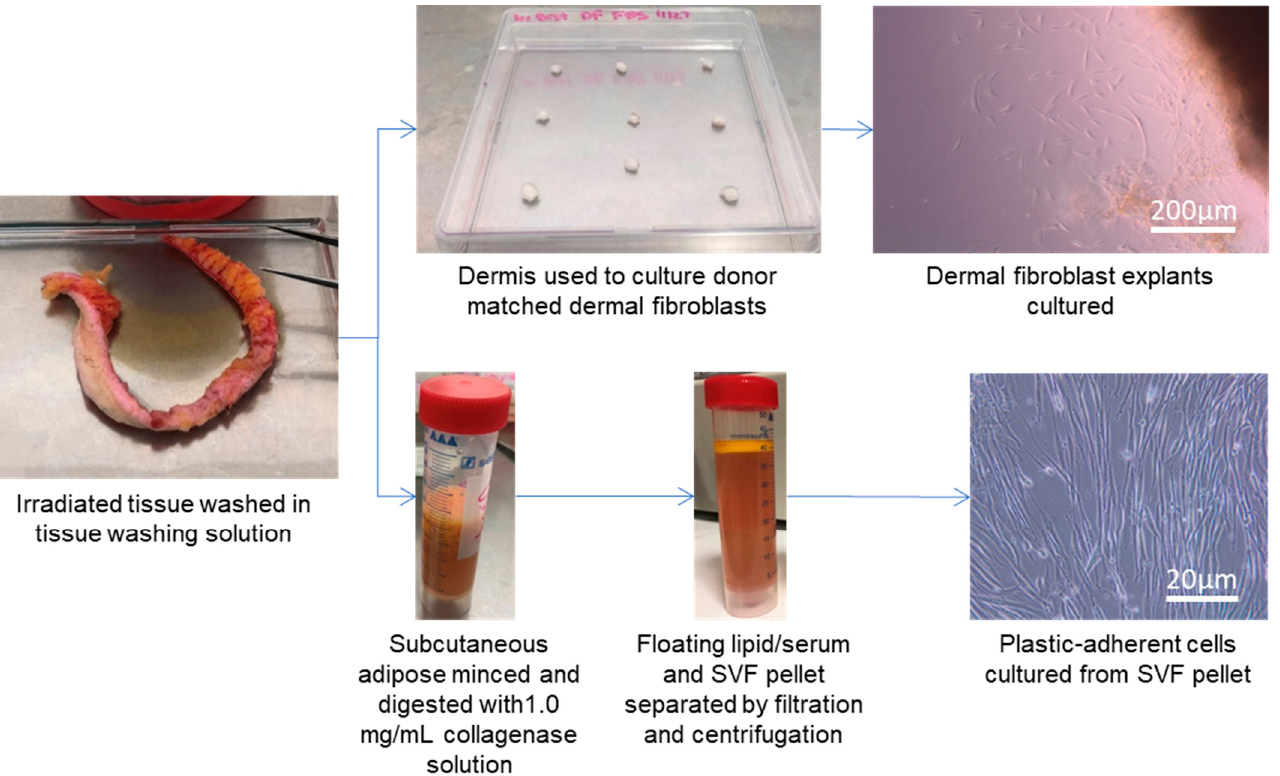
Figure 1. Optimised isolation of IR-SVF and DF from previously irradiated human breast tissue. Tissue was separated into two sections; one was used to isolate DF via an explant technique (dermal tissue can be seen as a dark region to the top right of the panel, with explanting cells radiating out of the tissue towards the bottom left corner). The second underwent mincing and digestion with 1.0 mg/mL collagenase, filtration, and centrifugation, before adherent cells from the IR-SVF were cultured. DF, dermal fibroblast; IR-SVF, stromal vascular fraction from irradiated tissue.